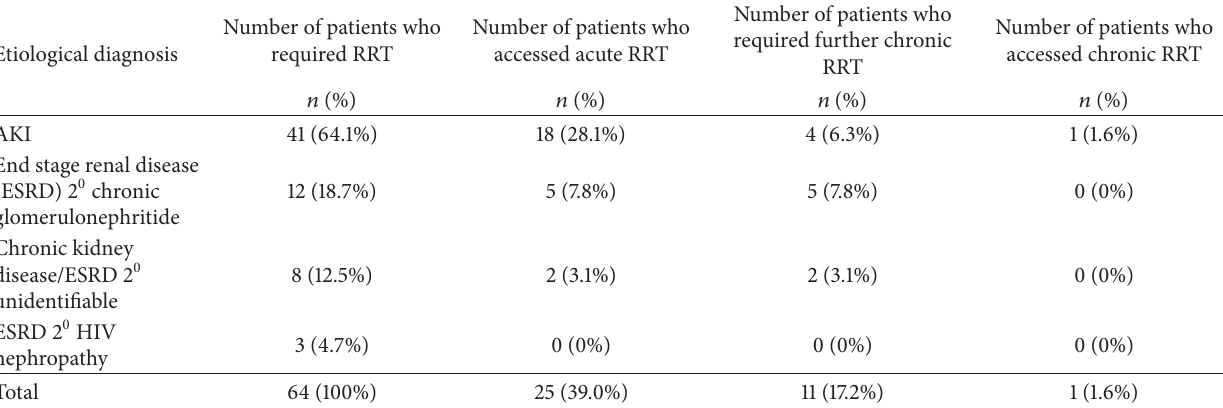
Table 2: Etiological diagnosis in patients who required RRT.